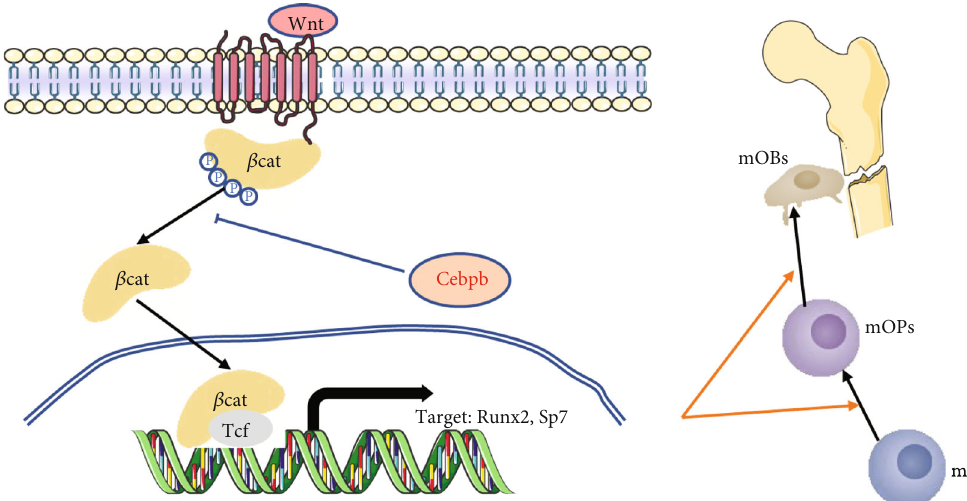
Figure 6: Schematic diagram of Cebpb in regulating mSSC di ff erentiation and fracture healing through WNT/ β -catenin signaling. β -cat: β - catenin; mSSCs: mouse skeletal stem cells; mOPs: mouse osteoprogenitors; mOBs: mouse